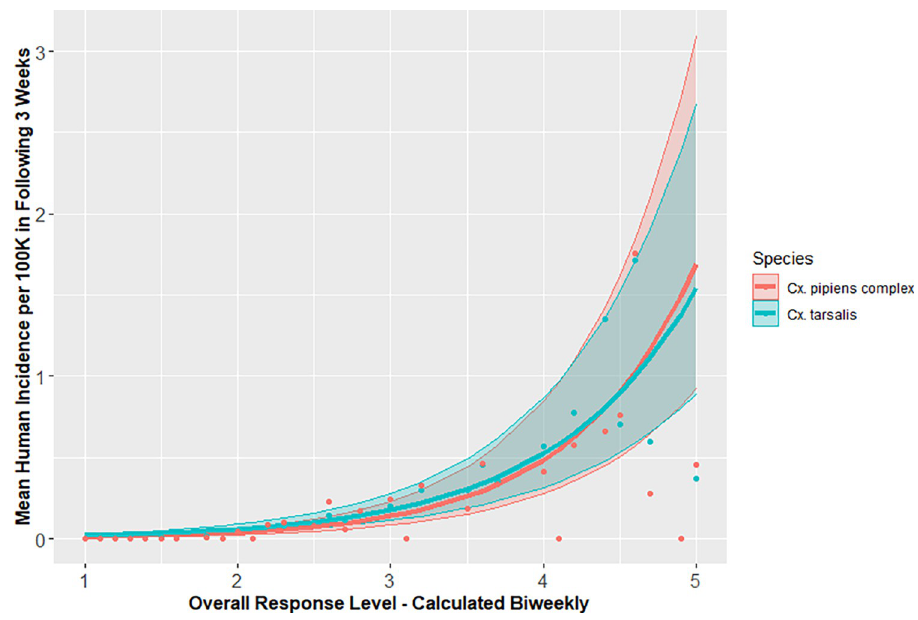
Fig 7. Predicted human WNV incidence estimated using California Mosquito-Borne Virus Surveillance & Response Plan, with 95% confidence intervals, with observed mean human WNV incidence (as points), in California, 2009–2018.